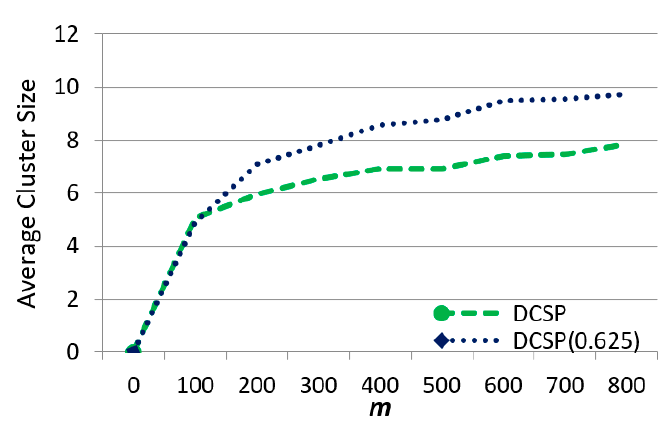
Figure 9. The effect of η on the total amount of used TTI.